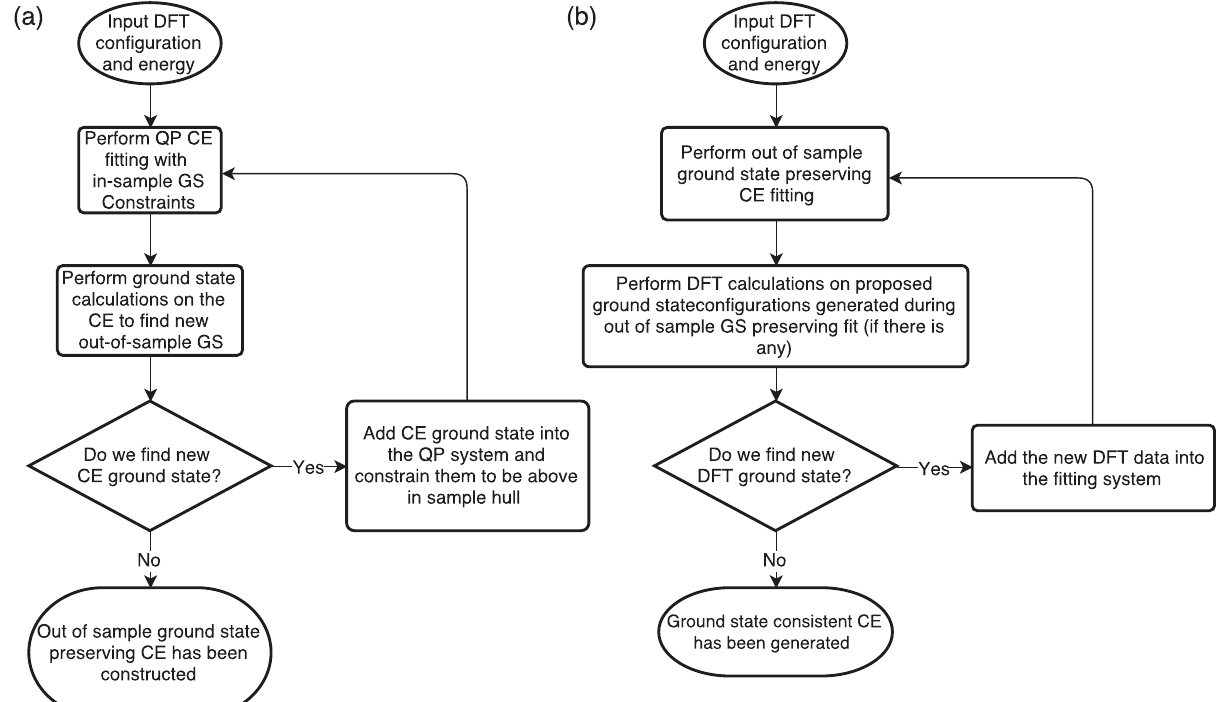
Fig. 5 a Flow chart of the iterative procedure for constructing out-of-sample ground-state preserving cluster expansion models. b Flow chart of a combined DFT-CE con fi gurational sampling resulting in the construction of ground-state consistent cluster expansion models as in Eq. (14). By iteratively calculating the ground-state hulls and adding further constraints, global ground-state preservation up to a large supercell size can be achieved. The procedure is illustrated in Fig. 5a. To demonstrate the convergence of this iterative re fi nement, we applied the procedure to the two model systems for supercell size of up to 16 sites. The weight adjustment procedure described above is used for comparison. Small initial weights, 10 − 4 , and energies of about 1 meV above the hull are assigned to the predicted new ground states. The results are shown in Fig. 6a for Li x Fe (1 − x ) O and Fig. 6b for Li x Ti (1 − x ) O. For reference, the fi gure also shows the results of an iterative re fi nement using the weight adjustment method. The maximum distance between the in- sample hull and the out-of-sample hull is plotted in the upper